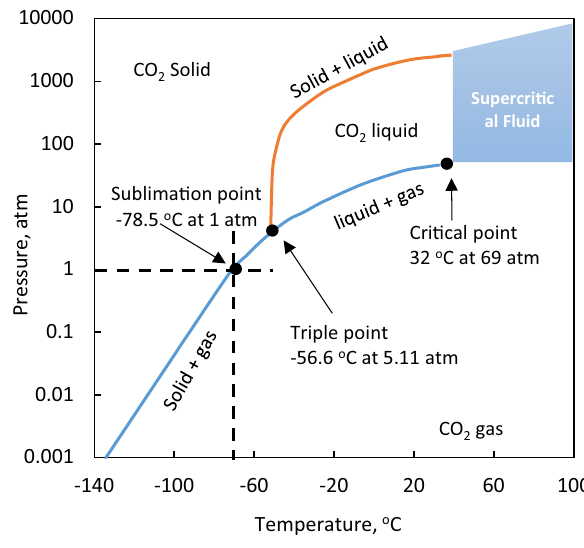
Fig. 1 CO 2 phase diagram [modified after (Oldenburg 2007; Waseem Arshad et al.